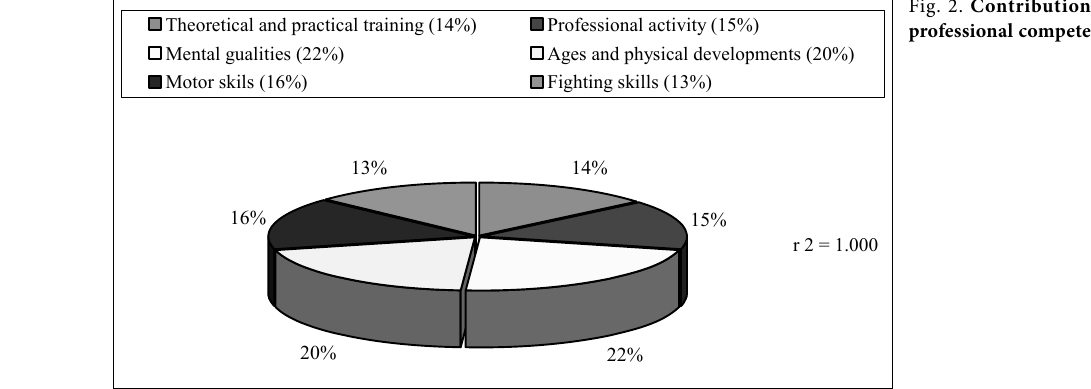
Fig. 2. Contribution of various factors to professional competence of